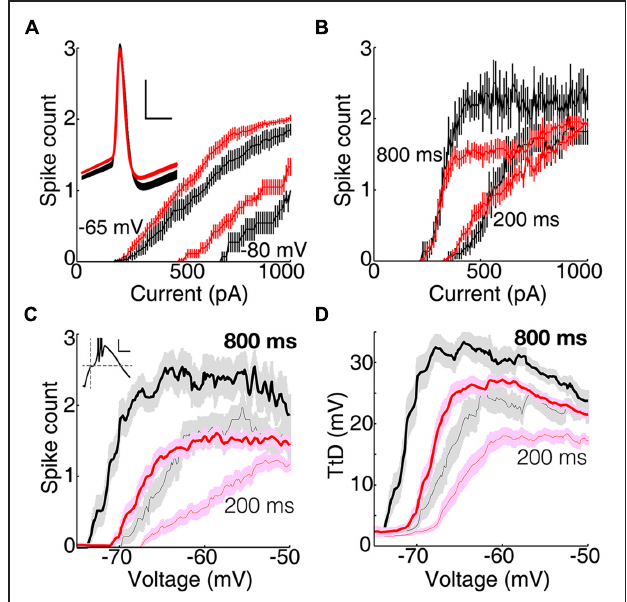
FIGURE 5 | T-type calcium channel activation causes more spikes in motor than visual thalamus. (A) Population mean ( ± SEM) firing rate as a function of current injected from near − 65 mV and after 50 ms near − 80 mV. Only a subset of 11 of 29 and 26 of 38 neurons in VL (black) and LGN (red), respectively, were tested at − 65 mV. Inset, population average action potentials (mean ± SEM) in VL and LGN selected to have peaks between 4.5 and 5.5 ms after onset of current injection from − 65 mV (scale bar: 2 ms, 20 mV). (B) Same as (A) but for currents injected after 200 and 800 ms at − 80 mV. (C) Same as (B) but as a function of initial depolarization. Inset, response from a single cell with dashed lines marking the time (10 ms) and amplitude of the initial depolarization (scale bar, 20 ms, 10 mV). (D) Same as (C) but showing population amplitude of the isolated TtD.